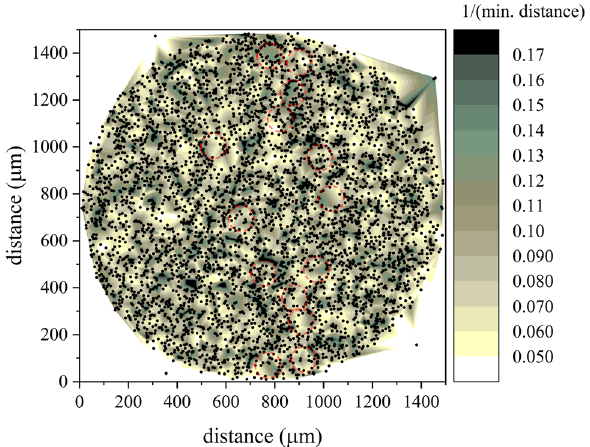
Figure 17. Proximity analysis diagram based on a buffer of reciprocal NND. Semitransparent circles show some correlated